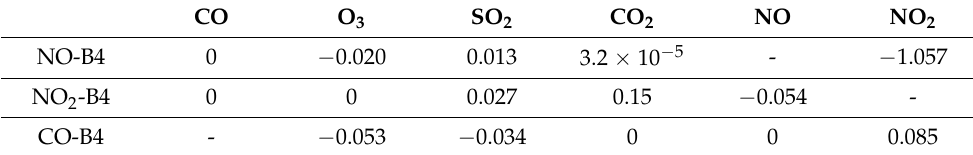
Table 3. Cross-sensitivity (in ppb/ppb), estimated from Lewis et al. (2016). Adapted from [17]. CO O 3 SO